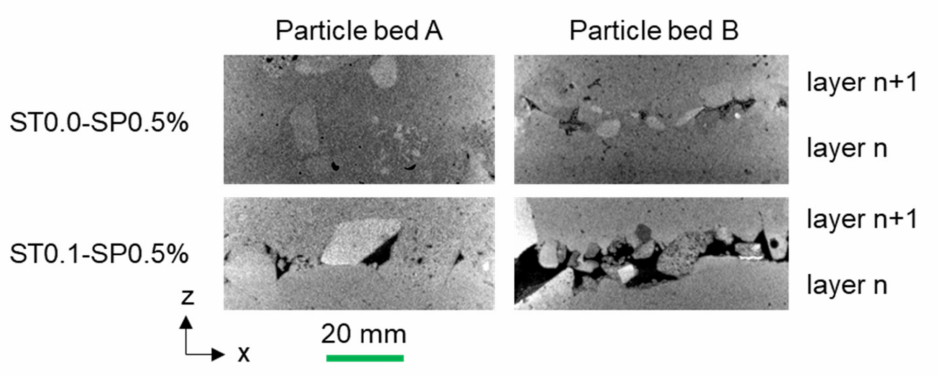
Figure 8. Exemplary µ CT investigations of the interlayer in between two strands of particle bed A ( left ) and particle bed B ( right ) with 0% ( top ) and 0.1% ( bottom ) stabilizer and 0.5% SP. Higher density appears white; lower density appears